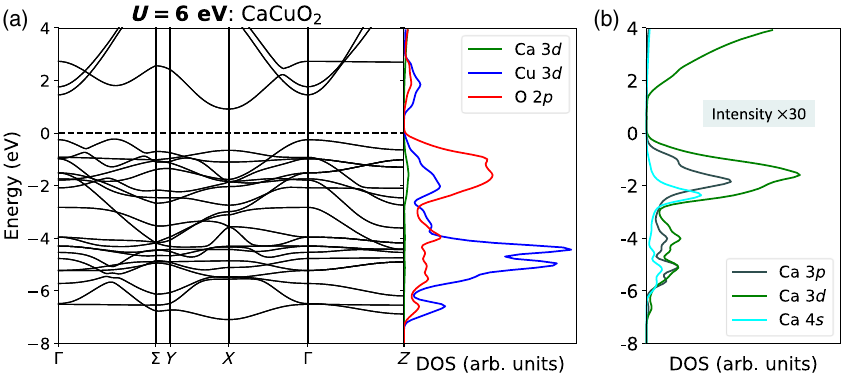
FIG. 7. Electronic structure calculation of CaCuO 2 . (a) Band structures and partial density of states of CaCuO 2 calculated by GGA þ U ( U ¼ 6 eV). (b) Zoom-in intensity of Ca partial density of states of CaCuO 2 calculated by GGA þ U (6